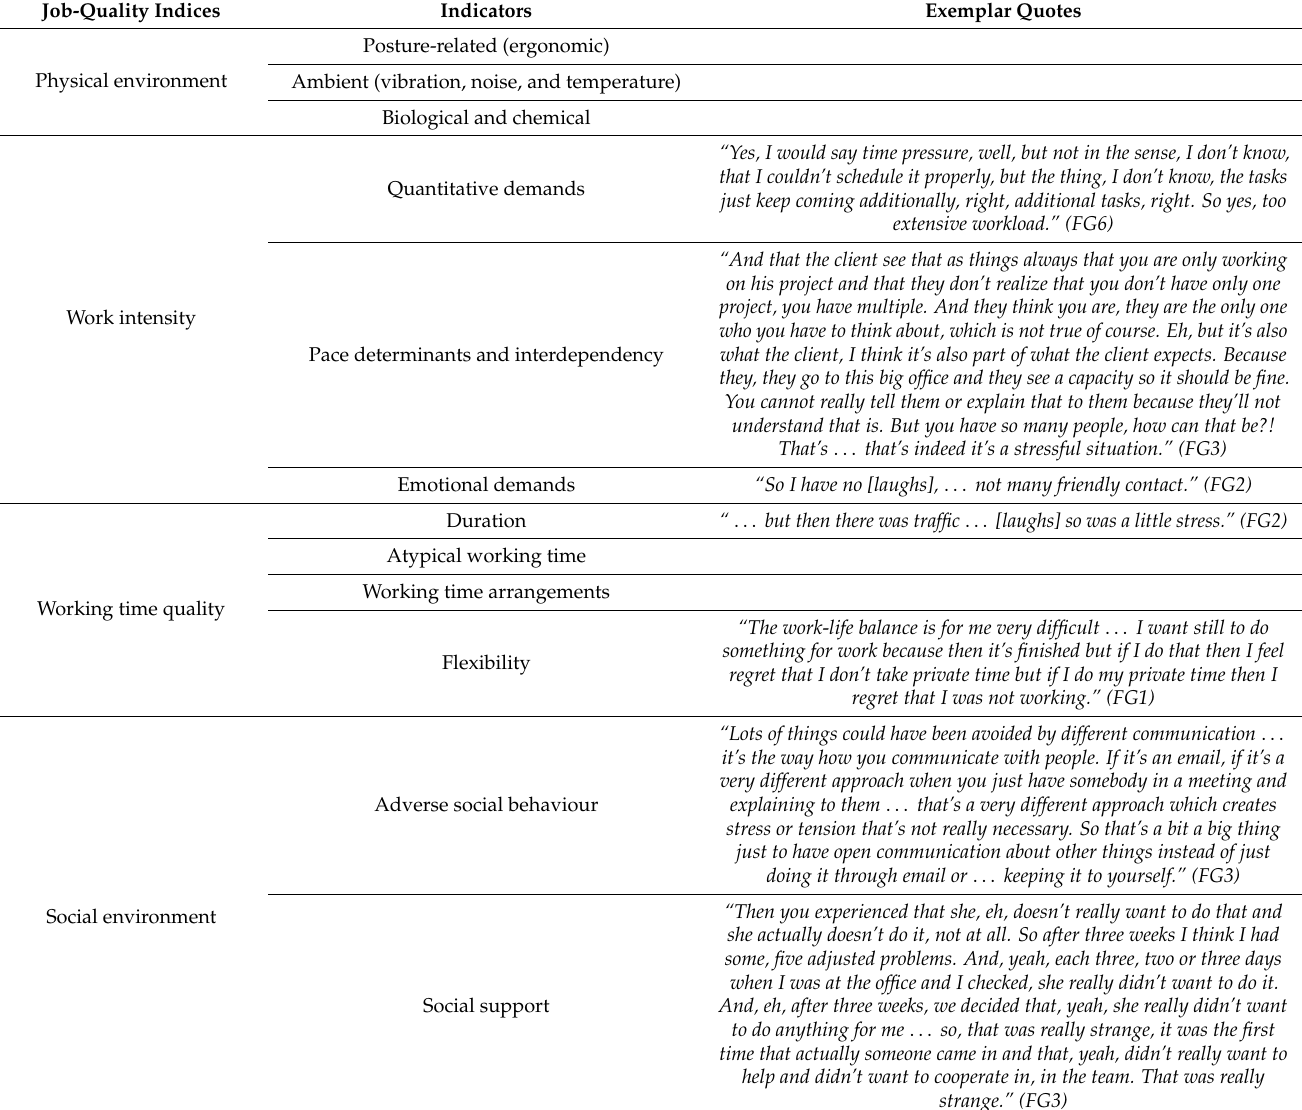
Table 1. Overview of the job quality indices and their indicators based on the EWCS [23] including exemplar quotes. An asterisk (*) signifies indices and indicators added based on the